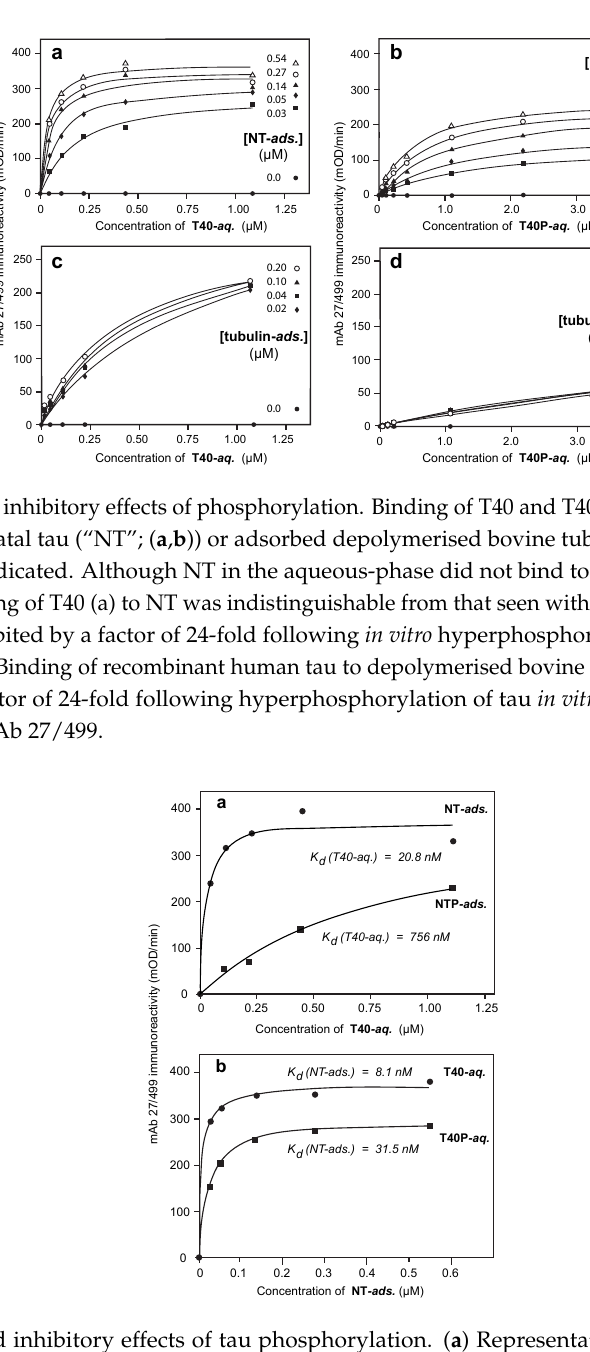
Figure 5. Induced inhibitory effects of tau phosphorylation. ( a ) Representative binding curves for nonphosphorylated T40 to adsorbed neonatal NT or NTP. Binding data is shown only for the case in which adsorbed neonatal tau was present at saturating concentration (>0.54 µ M) but, for calculation of the K d values shown here and in Table 2, binding was measured over the full range of NT concentrations shown in Figure 4. Prior hyperphosphorylation of neonatal tau (adsorbed NTP) inhibited binding of T40 in the aqueous-phase by a factor of 36-fold; ( b ) Representative curves for binding of adsorbed NT at saturating concentrations of T40 or T40P (>654 µ M and >4362 µ M, respectively). The corresponding solid-phase binding constants calculated from data obtained over the full range of aqueous-phase tau concentrations are shown. The effect of hyperphosphorylation of tau in the aqueous-phase is to reduce the binding affinity of the adsorbed species by a factor of